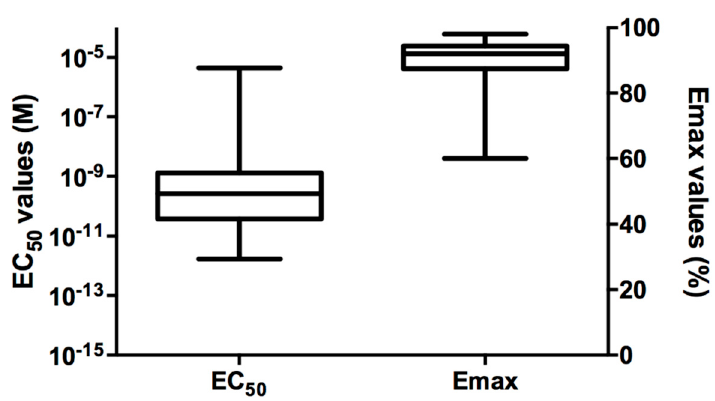
Figure 1. Distribution of EC 50 and Emax values measured by the MTT assay in monocytes from the 60 healthy volunteers exposed to PLTX for 4 h. For the monocytes of each volunteer, EC 50 and Emax values were the means of three experiments performed in triplicate.